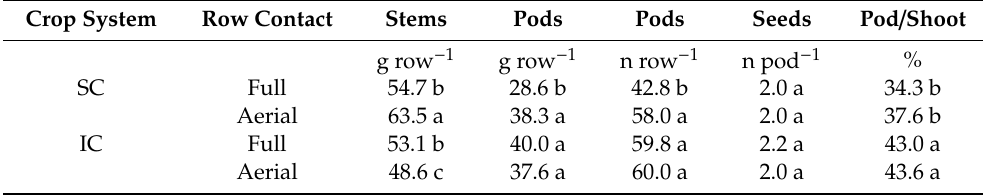
Table 3. Biomass of stems and pods, and pod-yield components in field bean, as a ff ected by the Crop System × Row contact interaction. SC, sole crop; IC, intercrop. For each parameter, values followed by the same letter within a column are not significantly di ff erent at P < 0.05, Tukey’s test. Crop System Row Contact